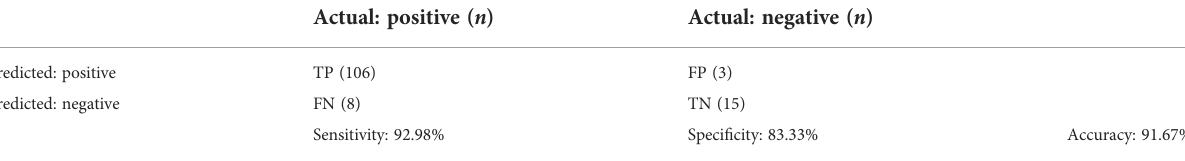
TABLE 3 Confusion Matrix and Testing Performance of the Model for Nerve Identi fi cation (Number of Nerve Structures, n =